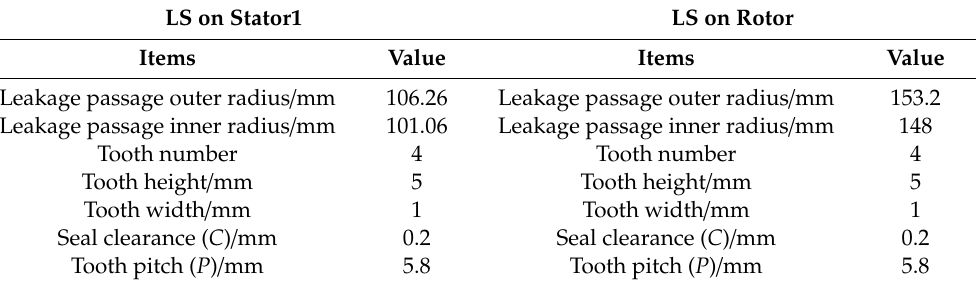
Table 3. The boundary